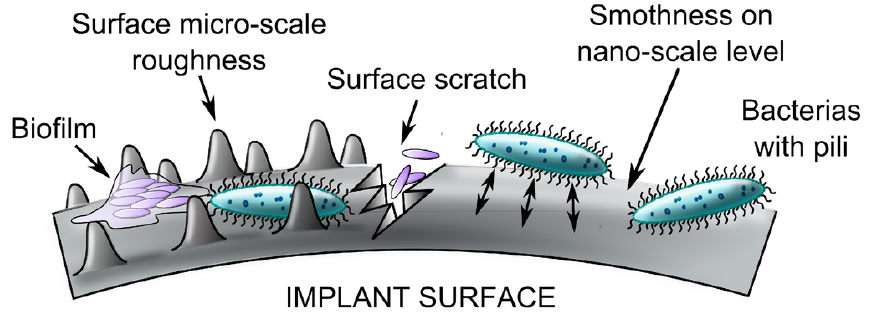
Figure 1. Interaction between biomaterial surface roughness and bacterial attachment [9]. Adapted